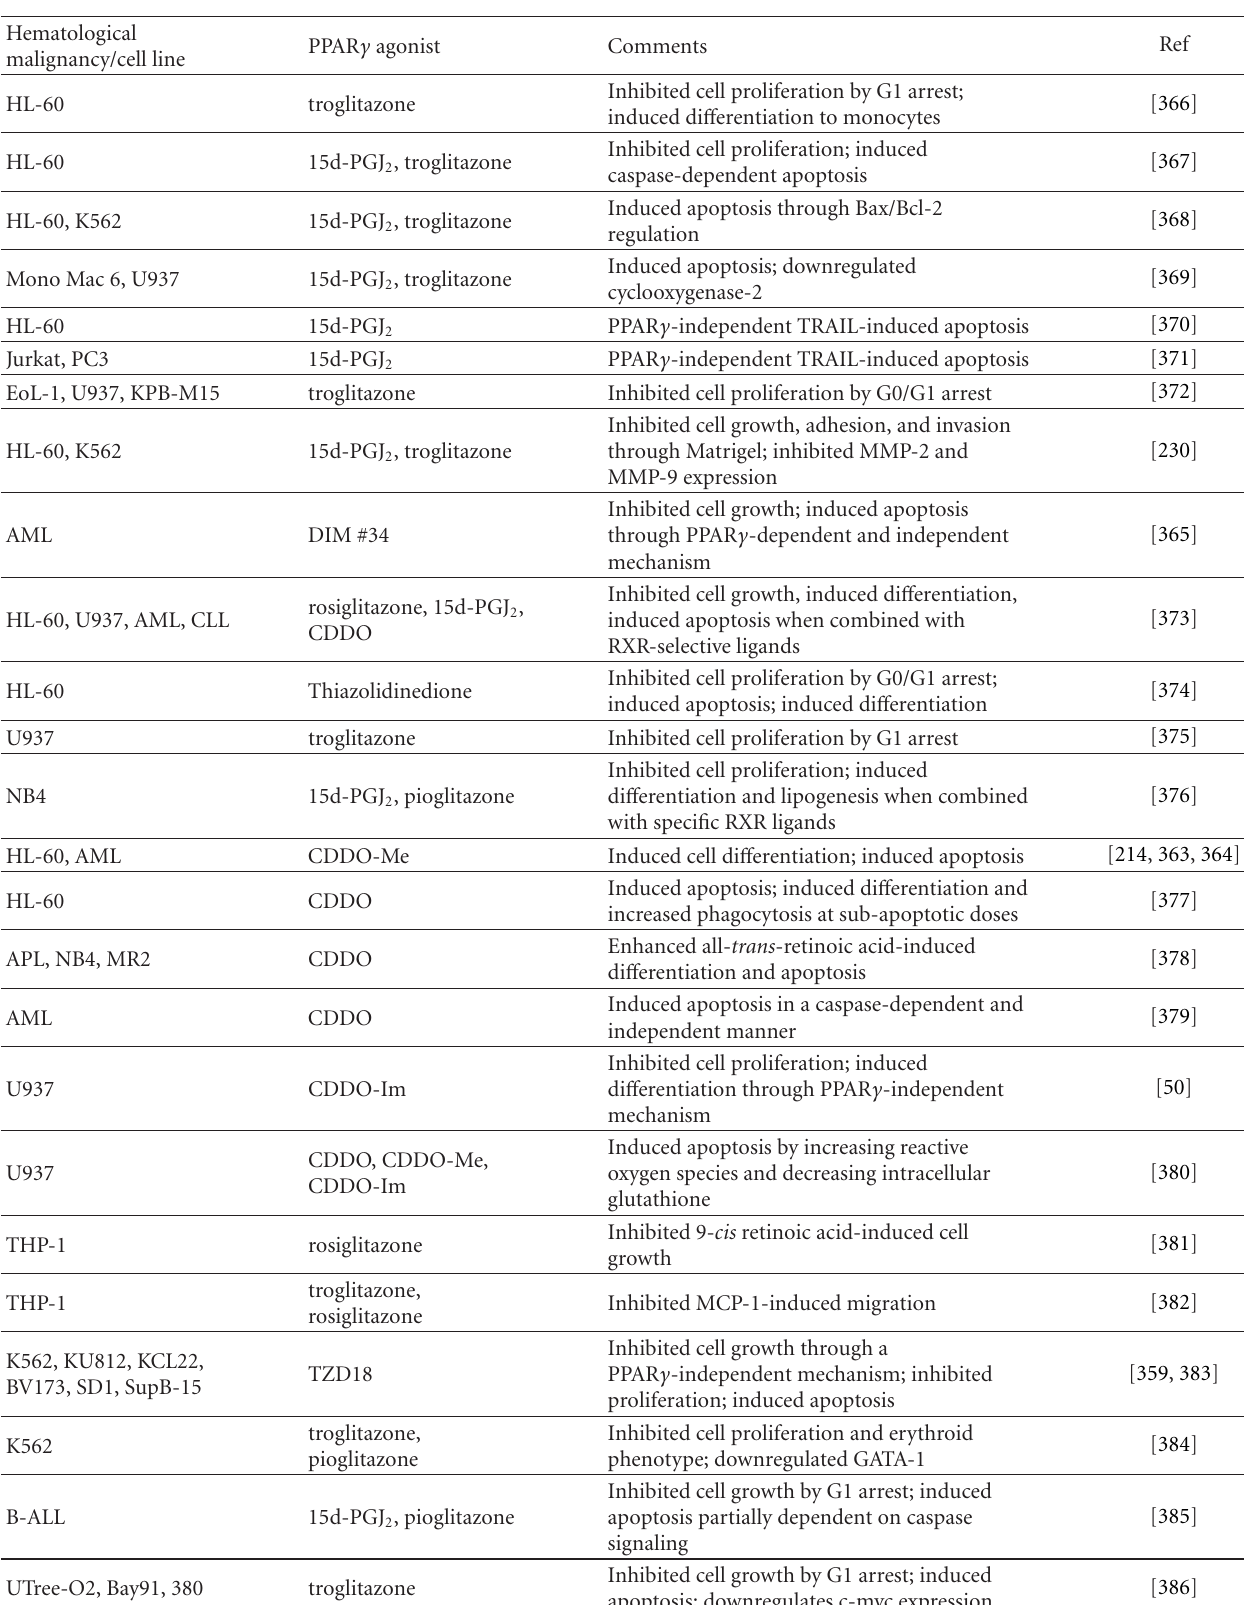
Table 2: PPAR γ and PPAR γ ligands as potential therapy for hematological malignancies.